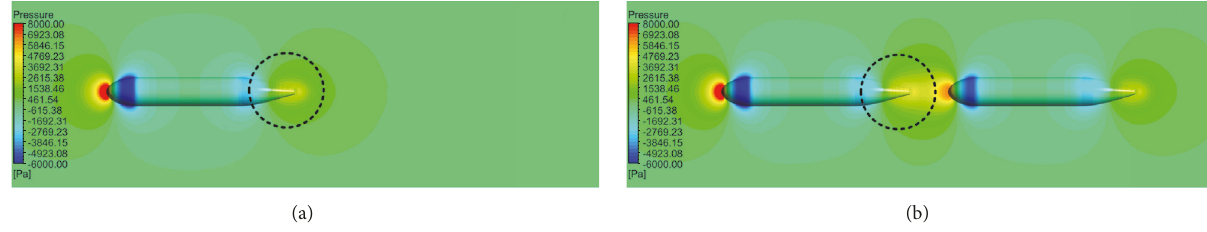
Figure 16: Contours of pressure around the AUV: (a) single AUV and (b) optimal AUV fleet.